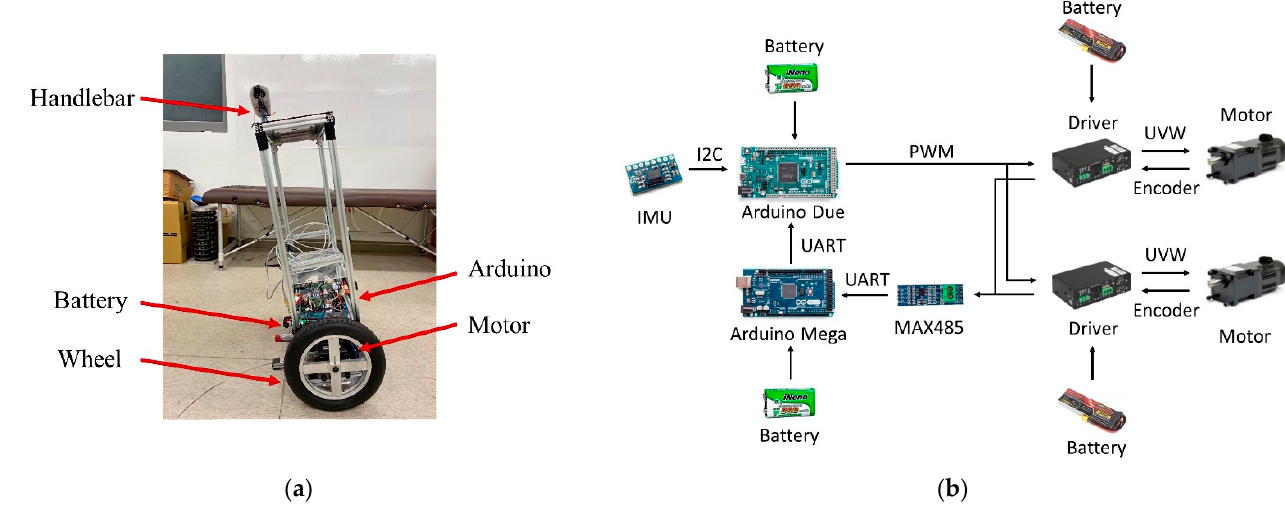
Figure 1. The TWIP system: ( a ) The prototype; ( b ) System architecture.